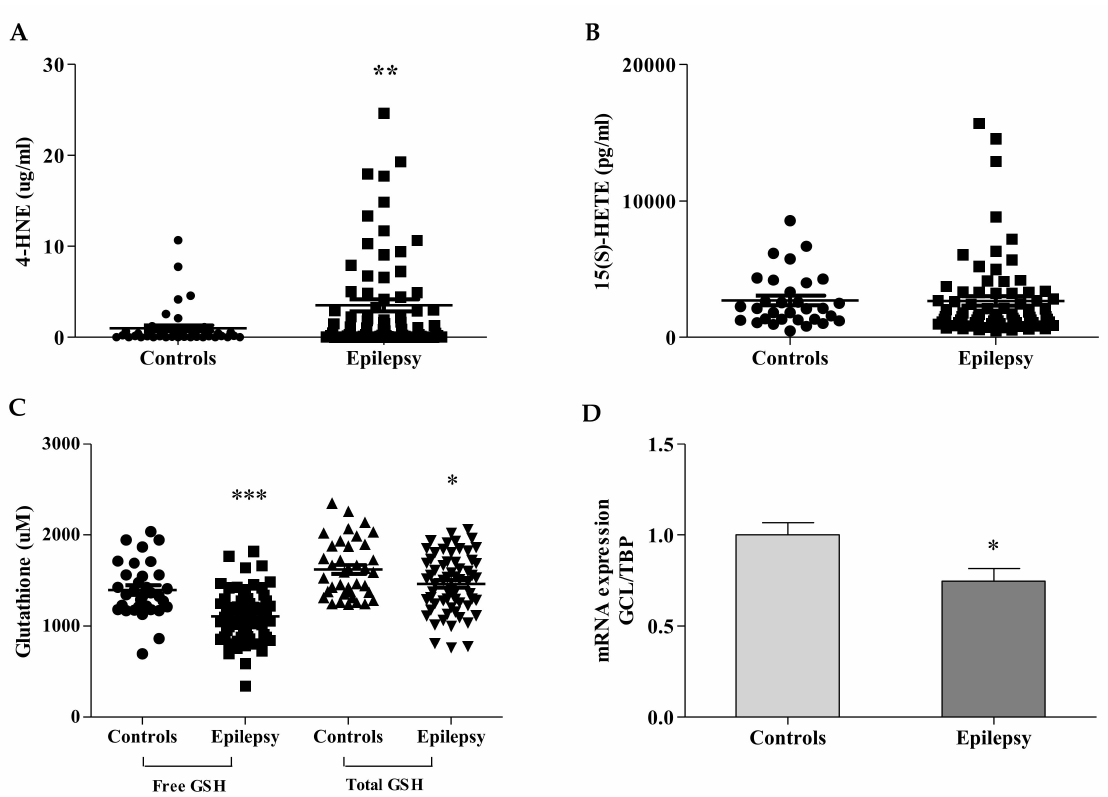
Figure 1. Ferroptosis biomarkers in blood of children with epilepsy. The lipid peroxidation products, 4-HNE ( A ) and 15 (S)-HETE ( B ), were measured in plasma of n = 83 patients and n = 44 controls ( n = 31 controls for 15(S)-HETE); GSH concentration ( C ) and GCL gene expression ( D ) were detected, respectively, in blood and leukocytes, as reported in Materials and Methods. Values are expressed as median ± SEM. Statistical significance was defined as * p < 0.05, ** p < 0.01, *** p < 0.001 respect to